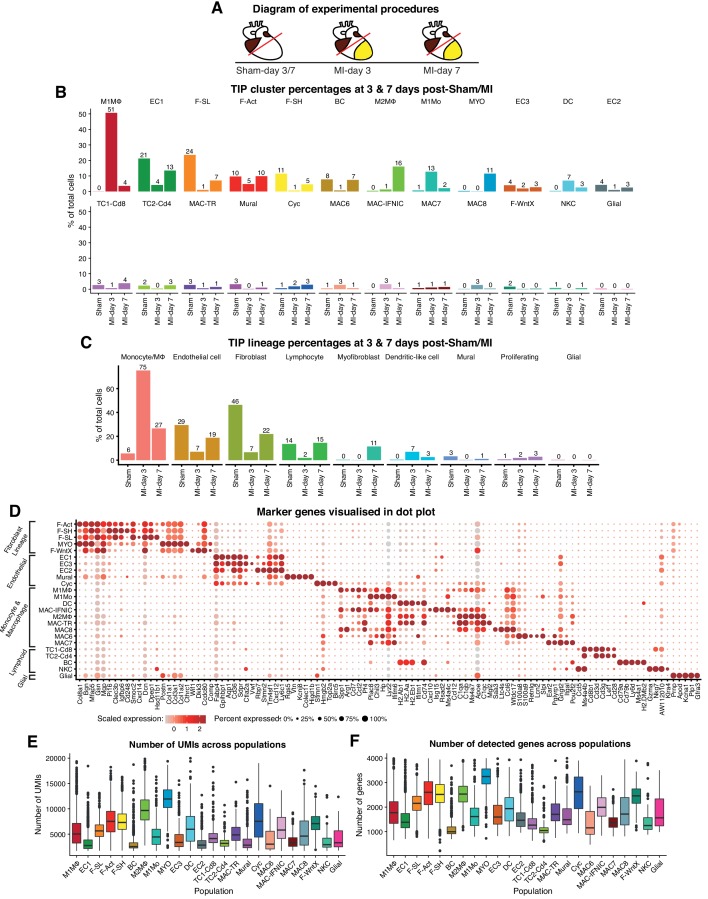
Experimental procedures, population proportions and gene expression characterstics of sub-populations within TIP scRNA-seq.(A) Diagram of experimental procedures. (B) Percentage of total cells in each cell-population according to experimental condition. (C) Percentage of total cells in clusters as grouped together according to high-level cell type and as according to experimental condition. (D) Dot plot showing expression of top upregulated genes across TIP populations. (E, F) Box plot showing number of UMIs (E) and genes (F) detected across TIP sub-populations after quality control filtering.